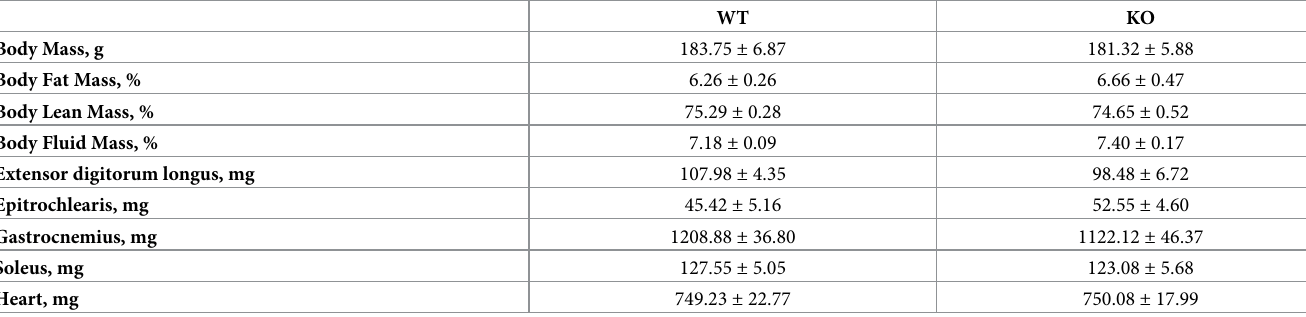
Table 1. Body mass, body composition and tissue masses.